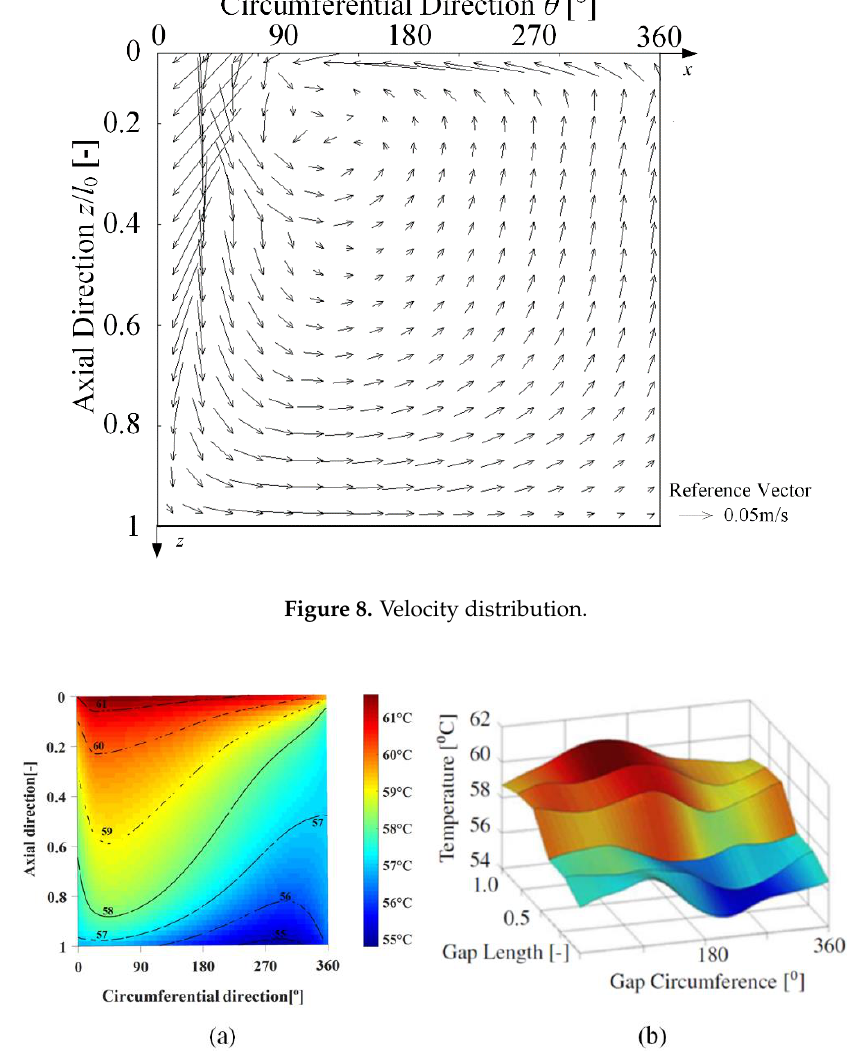
Figure 9. ( a ) Simulated temperature distribution; ( b ) Measured temperature distribution by experiment [22].